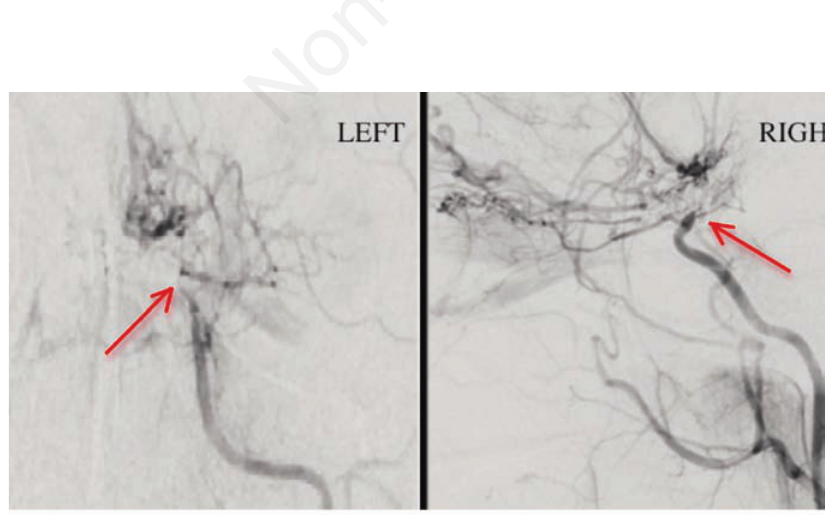
Figure 2. Case #1. Biplanar cerebral angiography of the left internal carotid artery (A and B, lateral and AP respectively) demonstrated complete occlusion of the left supraclinoid internal carotid artery with a patent left anterior choroidal artery supplying lenticulos- triatal vessels giving the angiographic appearance of a I, suggestive of Moyamoya angio- graphic pattern. Collateral flow from the right posterior choroidal artery supplying the pericollosal, frontopolar and callosmarginal arteries demonstrated on lateral view on selective angiogram of the left vertebral artery (C). Intracranial view of the right inter- nal carotid artery in the AP projection (D) demonstrates an irregular M1 segment and complete occlusion of the mid A1 segment of anterior cerebral artery. Cortical branches also appeared irregularity consistent with a proliferative intracranial vasculopathy.